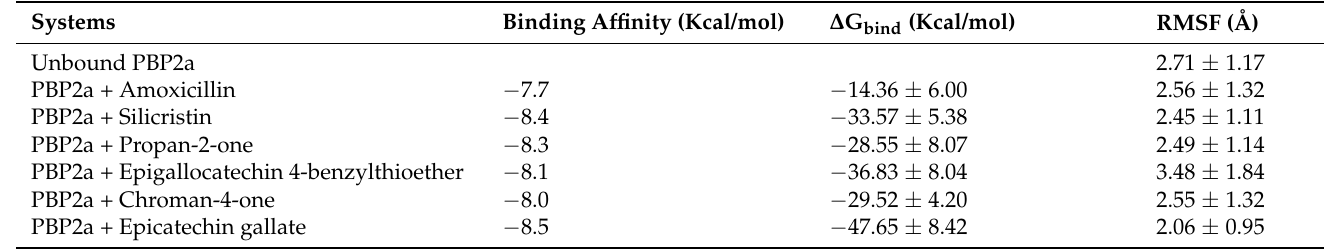
Table 5. Molecular docking, binding free energy and RMSF values of the top-five phenolics at the allosteric site of PBP2a of S. aureus